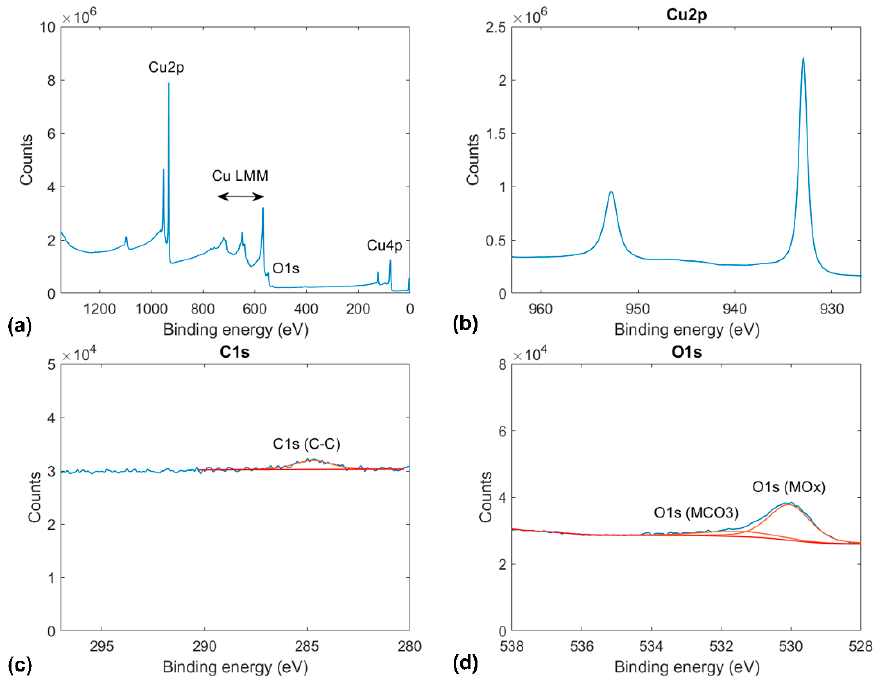
Figure 1. Indexed X-ray photoelectron spectroscopy (XPS) results for annealed copper: ( a ) full x-ray photoelectron spectrograms and spectrograms for the ( b ) Cu2p, ( c ) C1s, and ( d ) O1s orbitals.